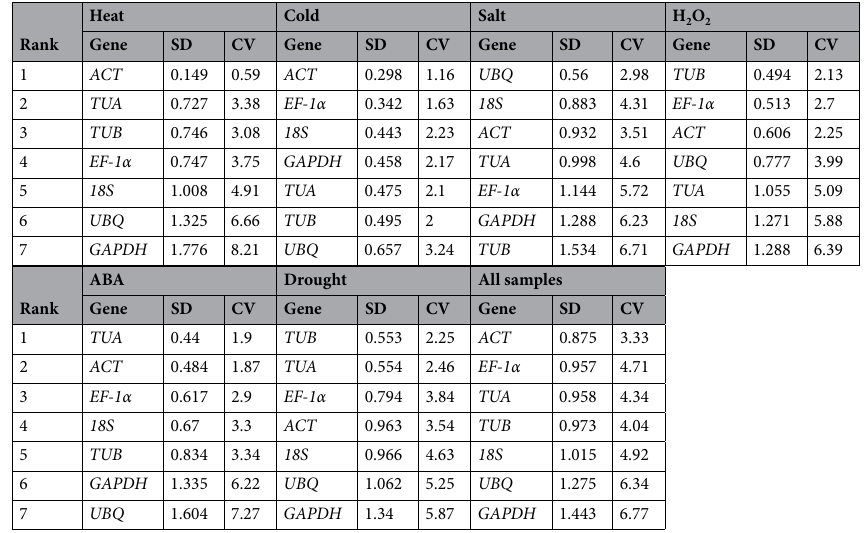
Table 3. Expression stability of seven reference genes following various treatments based on a BestKeeper analysis.